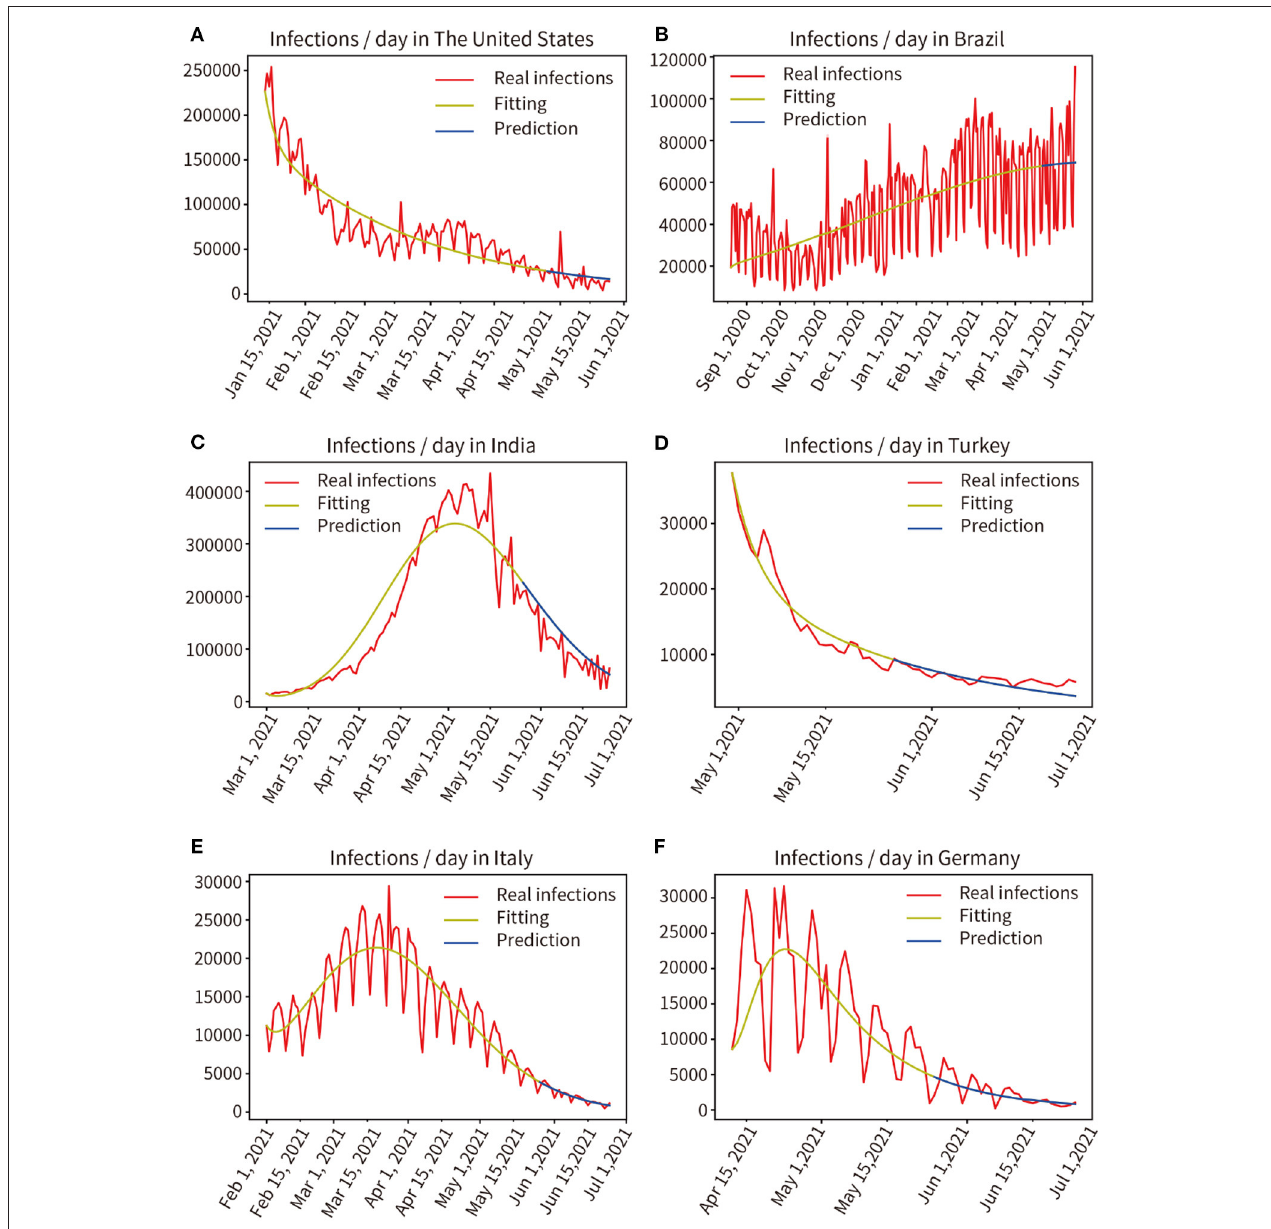
FIGURE 9 | Real infected individuals are represented by the red curve. Fitted infections are represented by yellow curves. Predicted infections are shown as blue curves. (A) The United States, (B) Brazil, (C) India, (D) Turkey, (E) Italy, (F) Germany.